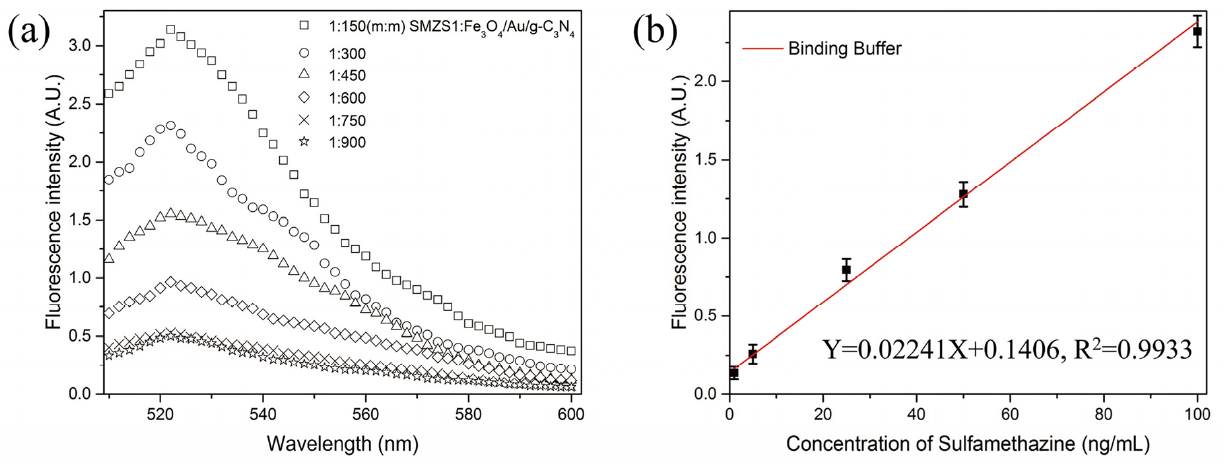
Figure 3. ( a ) Fluorescence emission spectra of SMZ1S:Fe 3 O 4 /Au/g-C 3 N 4 of different qualities. ( b ) The standard curve of the aptasensor used to detect different concentrations of SMZ in binding buffer.